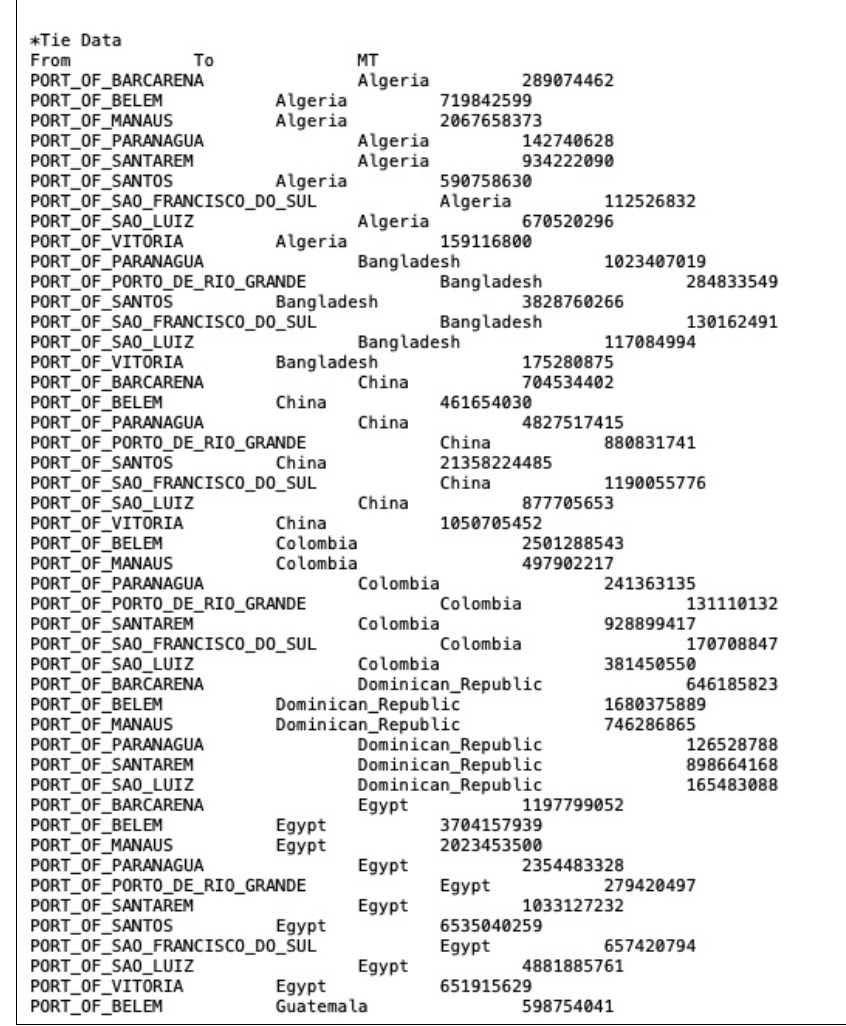
Figure 1. Vna text